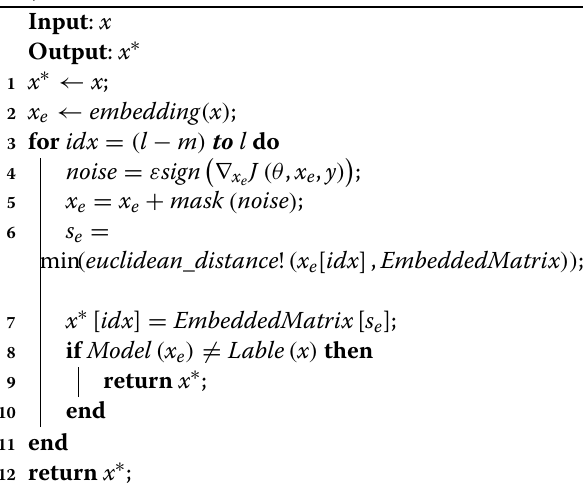
not destroy the original features, but only adds pertur- bation in the padding part. This is because the mask operation is adopted to cover up the real sequence in the perturbation algorithm and prevent the algorithm from modifying it. The pseudo-code is described in Algorithm 1.